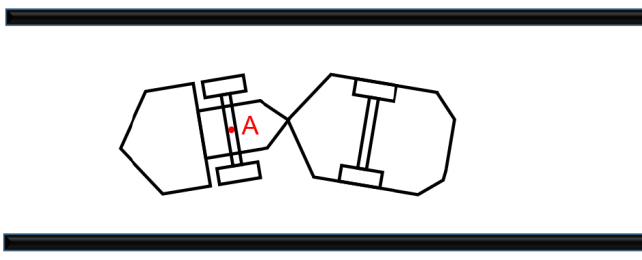
Figure 11. The installation position of 3D LIDAR. Sensors 2022 , 22 , x FOR PEER REVIEW